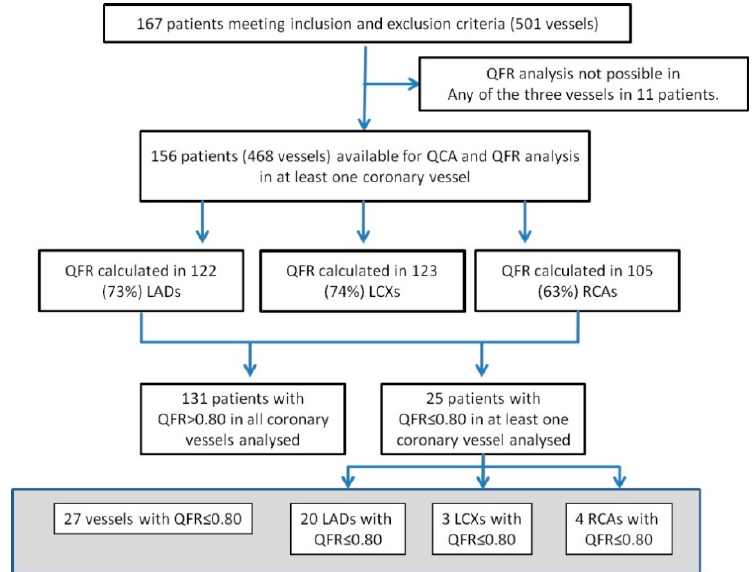
Figure 1. Study Flow Chart. QFR: Quantitative Flow Reserve; QCA: Quantitative Coronary Analysis; LAD: Left Anterior Descending Artery; LCX: Left Circumflex Artery; RCA: Right Coronary Artery.